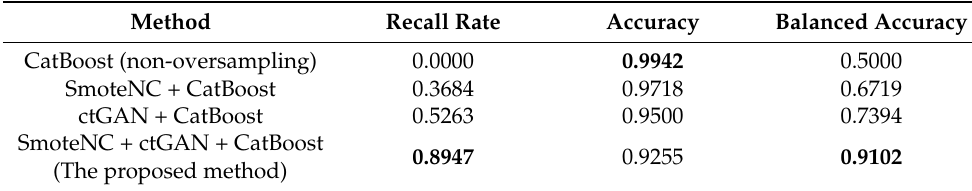
Table 8. Prediction results obtained for the TWF diagnosis using other methods used for processing limited data.